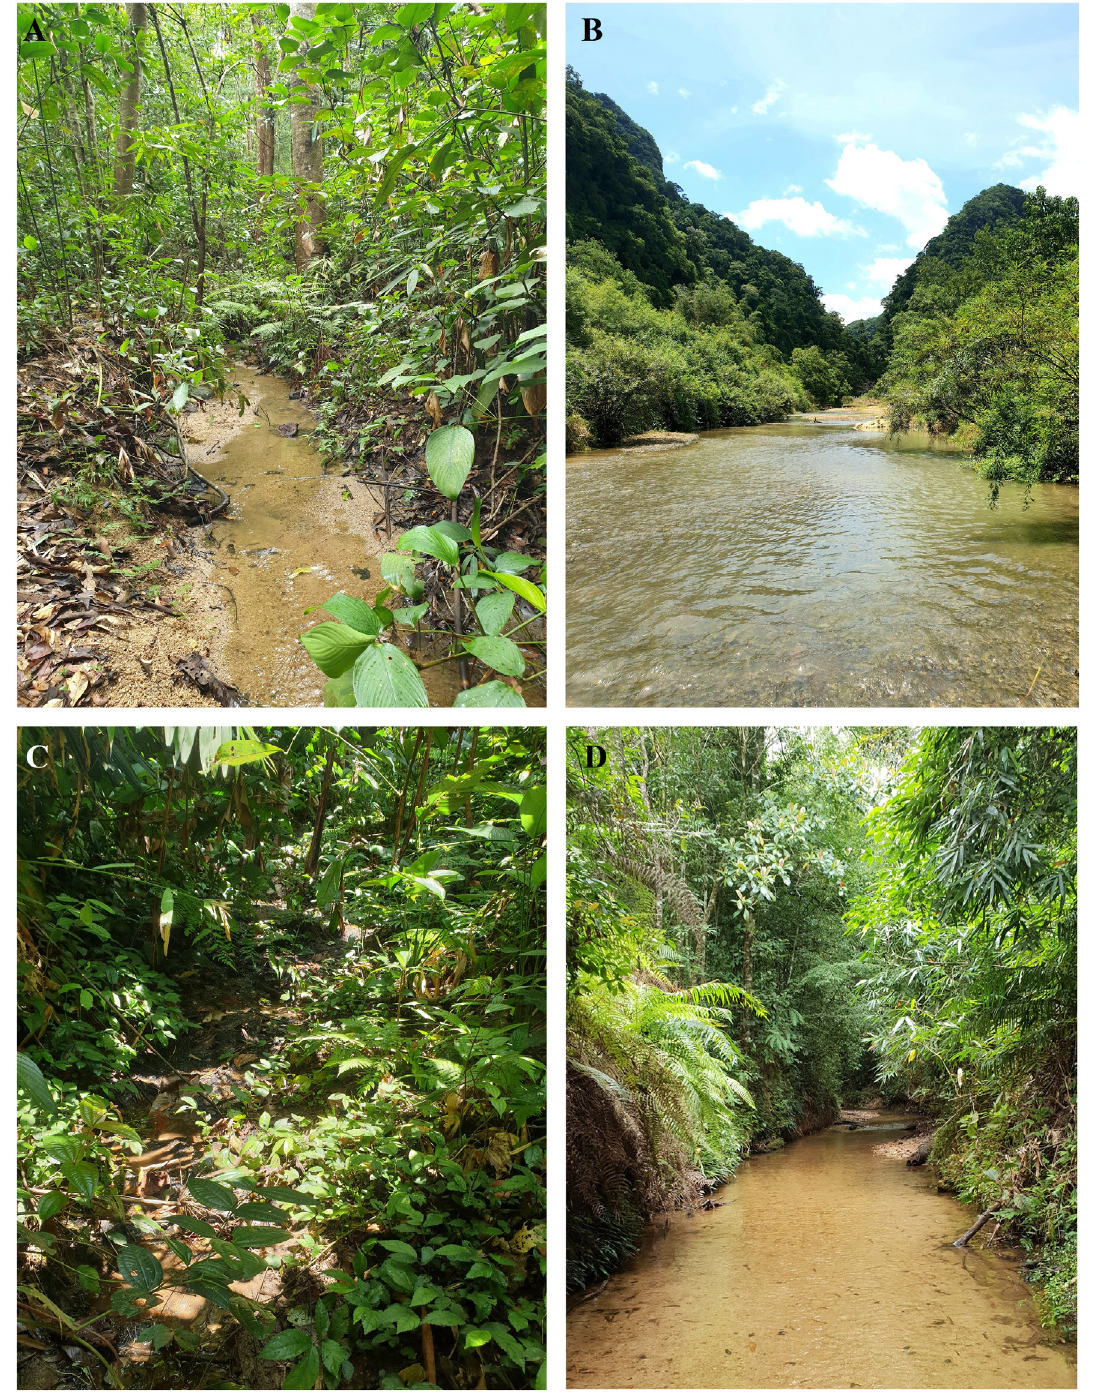
Fig. 16. Habitat of Prodasineura Cowley, 1934 spp. in Vietnam. A . Gia Trang stream in Chu Mom Ray National Park, home of P. doisuthepensis Hoess, 2007 and P. verticalis Selys, 1860. B . Typical stream where P. lancastrei sp. nov., P. autumnalis (Fraser, 1922) and P. croconota Ris, 1916 occur, in Pu Mat National Park. C . Open limestone stream in Tan Hoa Commune, Minh Hoa District of Quang Binh Province with three species: P. autumnalis , P. kong sp. nov. and P. coerulescens (Fraser, 1932) coexisting. D . Habitat of P. hoffmanni Kosterin, 2015 and P. autumnalis in Mang Canh, Kon Plong District of Kon Tum